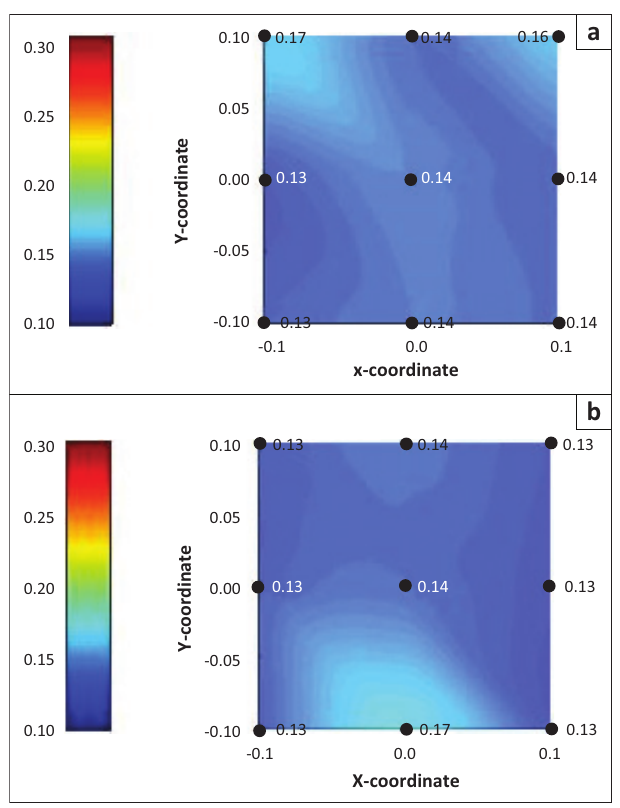
FIGURE 5: Pseudo-3D maps illustrating mean oscillatory threshold for (a) test and (b) retest measurements at each of the nine points within the macular field test for the sample ( n = 26). (a) test and (b) retest.